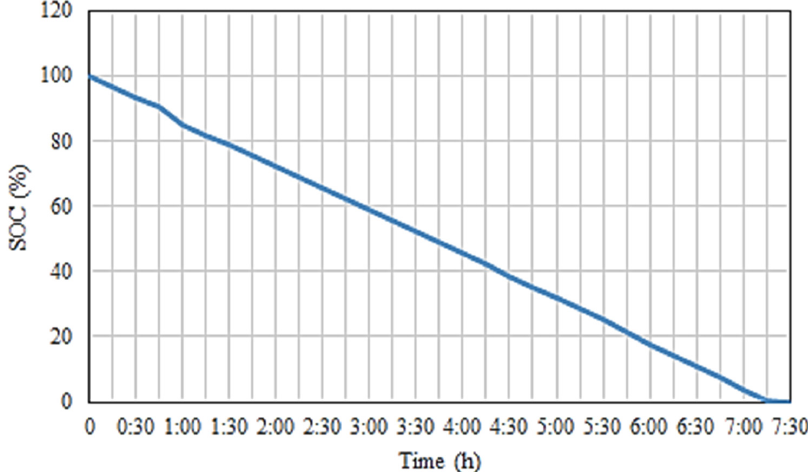
Figure 12. Change in the battery SOC during discharge of Test 3.